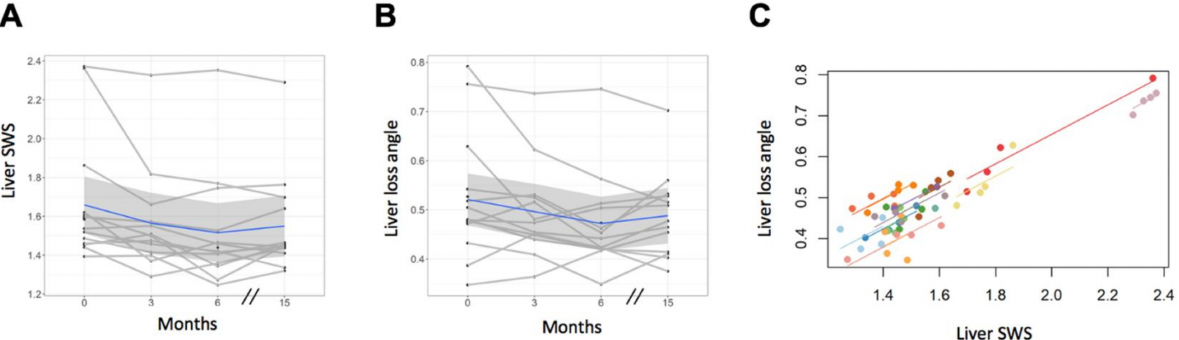
Figure 5. Results of liver tomoelastography after antiviral treatment. ( A ) Decrease in liver shear wave speed (SWS), accompanied by ( B ) reduced loss angle of the complex shear modulus ( ϕ ) at FU1, and SWS at FU2 compared with baseline (at FU1 for SWS p = 0.005, and for ϕ p = 0.038; at FU2 for SWS p = 0.47, and for ϕ p = 0.195). In one patient who suffered viral relapse with constant high values in ( A , B ), no substantial changes in SWS and ϕ were observed. ( C ) Analysis of repeated-measures correlation showed a strong correlation between SWS and ϕ ( r = 0.81, CI = 0.67–0.90). EOT, end of treatment; FU1, follow-up 1; FU2, follow-up